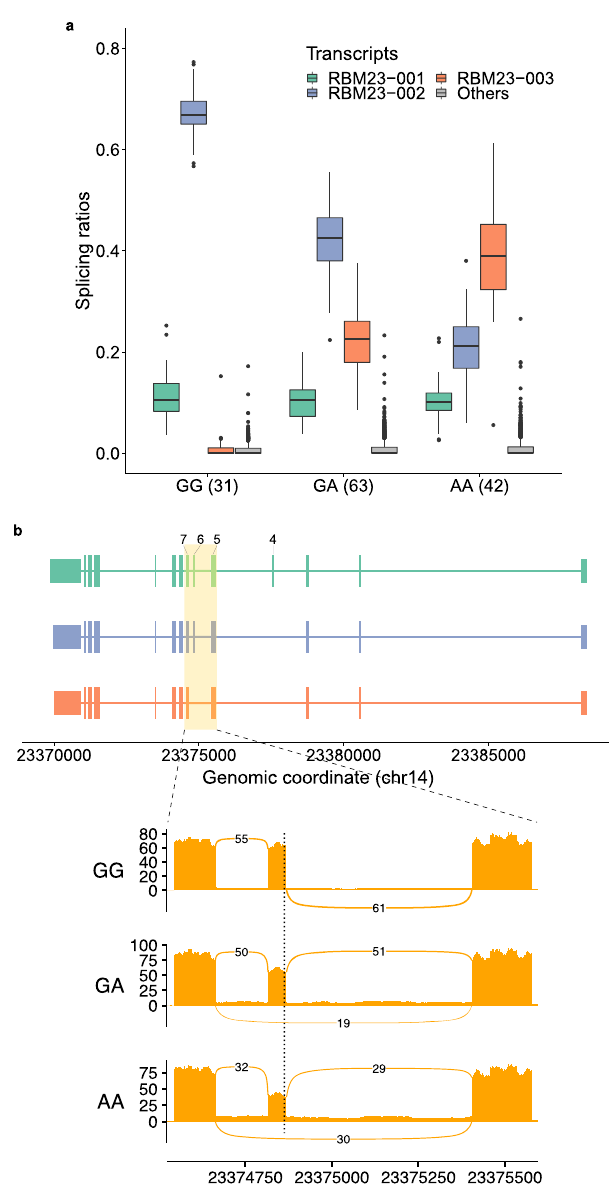
expected), escape the general trend. This was also observed for